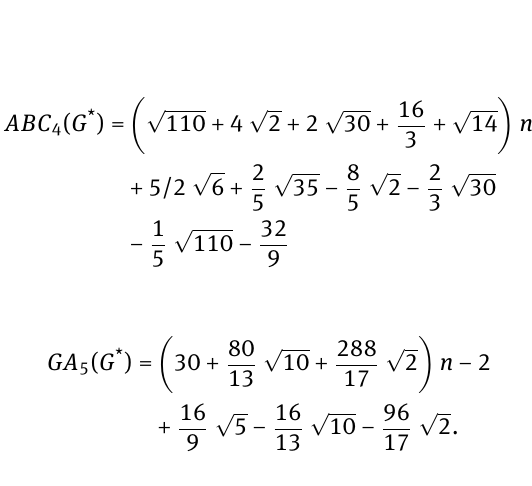
Figure 2: Linear